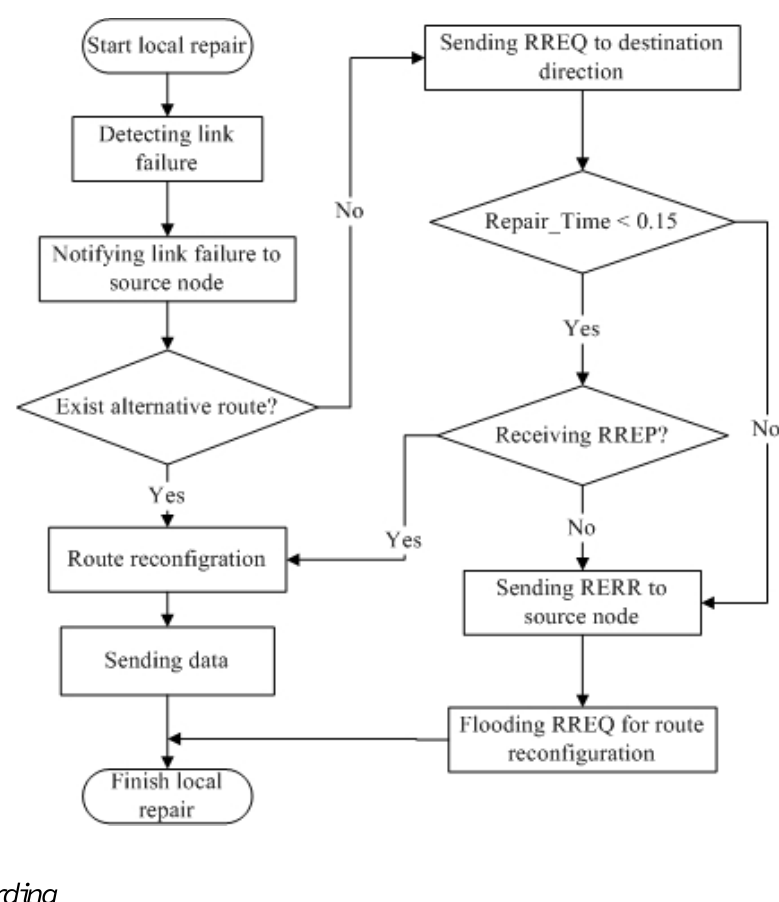
Figure 4. Local repair flow